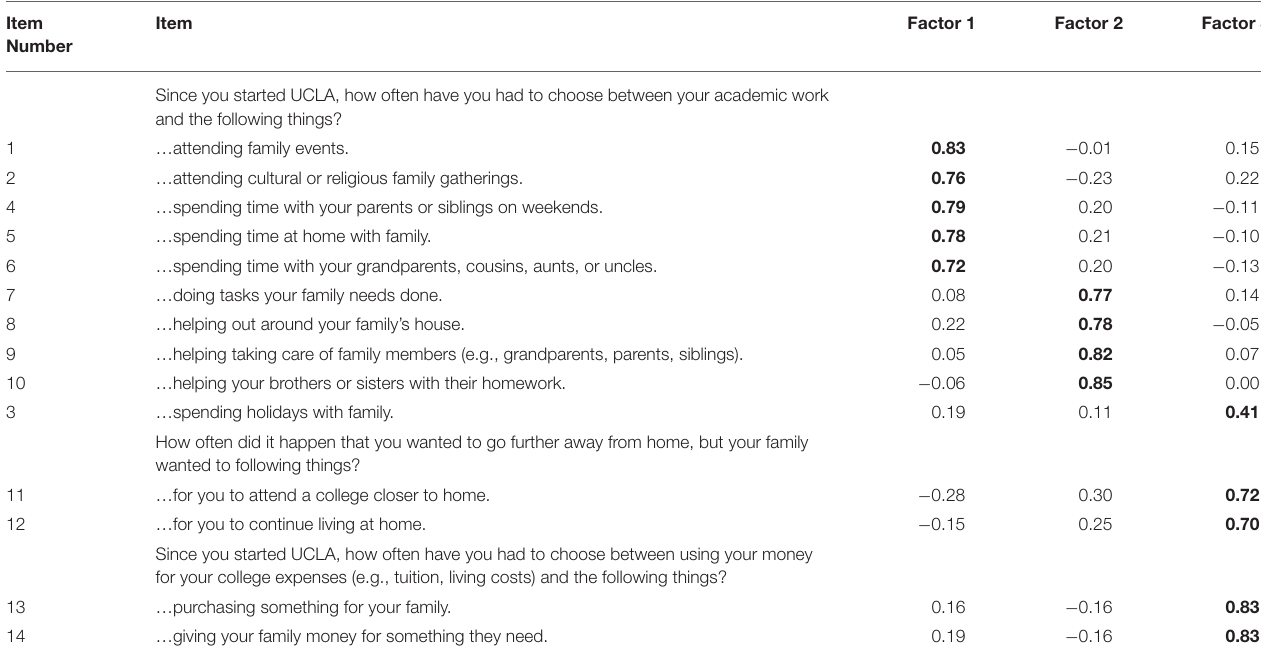
TABLE A1 | Principal components correlation matrix for home-school cultural value mismatch scale. Item